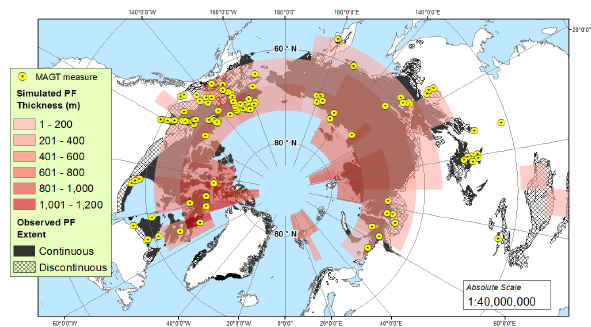
Figure 12. Map showing locations of the MAGT measurements, collected for the International Polar Year (IPY) 2010 (GTN-P), used in the comparison to corresponding i LOVECLIM simulated subsur- face